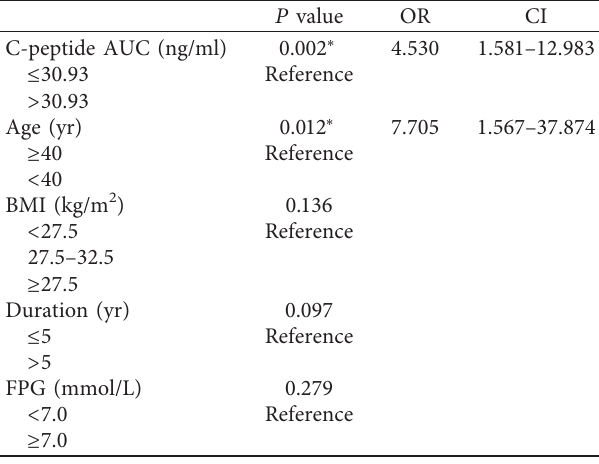
Table 3: Binary logistic regression of short-term remission